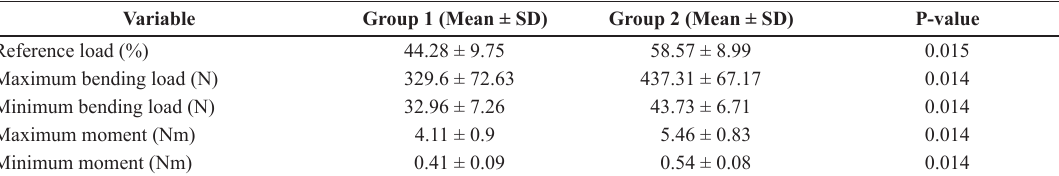
Table 5. Mean values and standard deviation (SD) for each variable evaluated in Groups 1 and 2 under fatigue four-point bending testing.